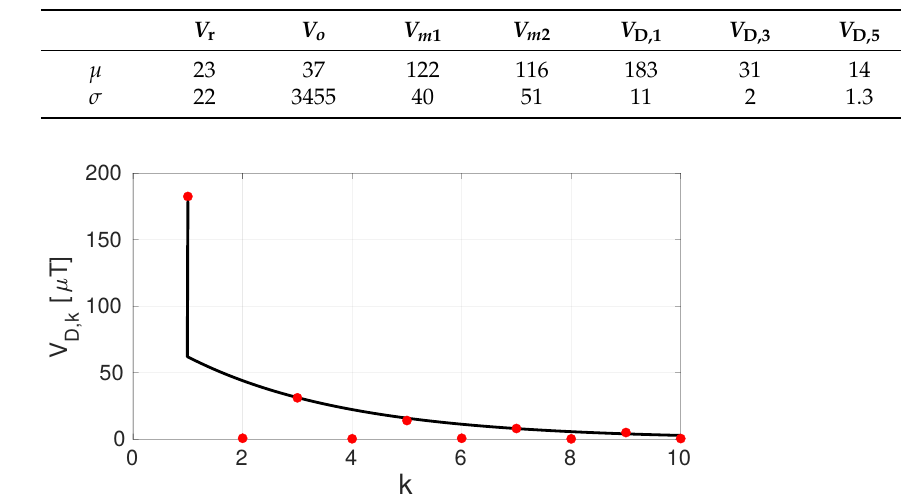
Table 1. Normal distribution fit on the input-referred offset terms from (10) in µ T using 10 samples of the ILSA prototype chip with randomized Hall plate spinning.